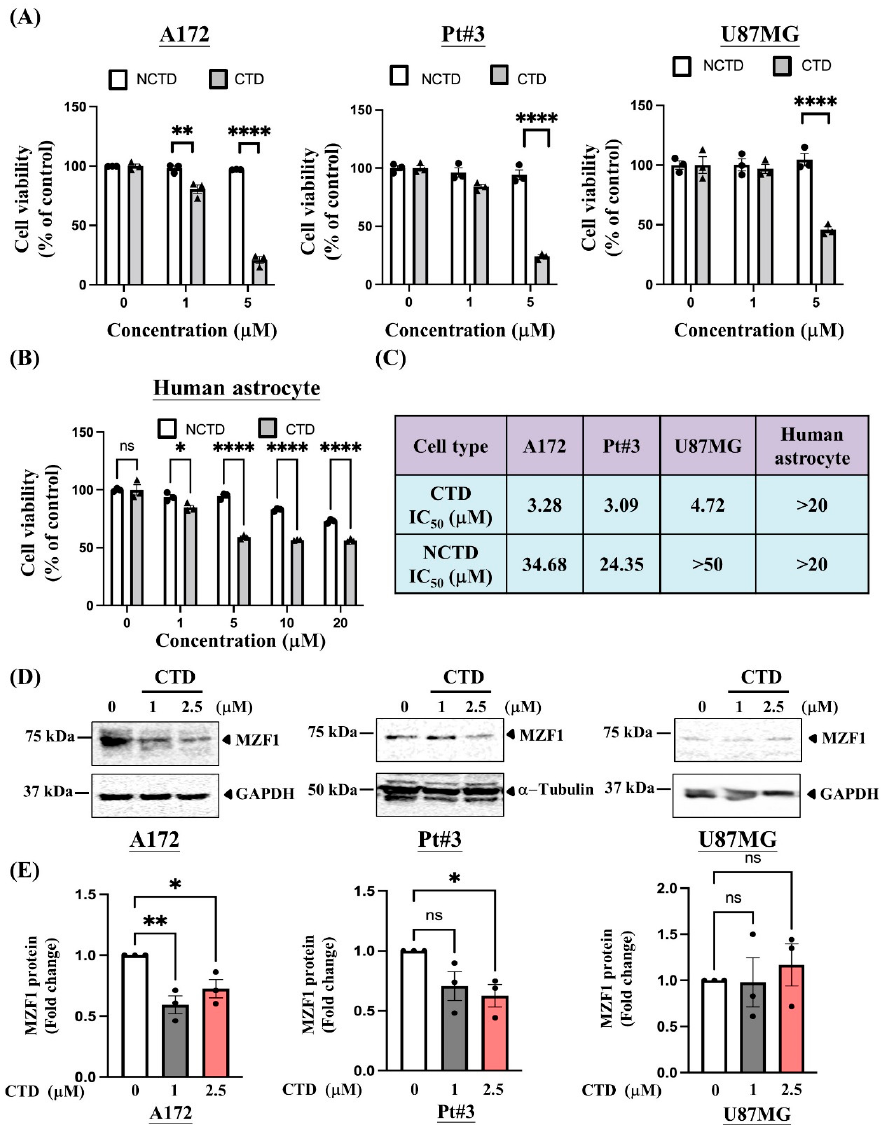
Figure 4. Cantharidin (CTD) reduces cell proliferation by inhibiting MZF1 expression. ( A ) Low-dose CTD significantly inhibited cell survival more than low-dose NCTD in glioma cells (A172, PT#3, and U87MG). The cell viability was determined using the CCK-8 assay. Data are collected from at